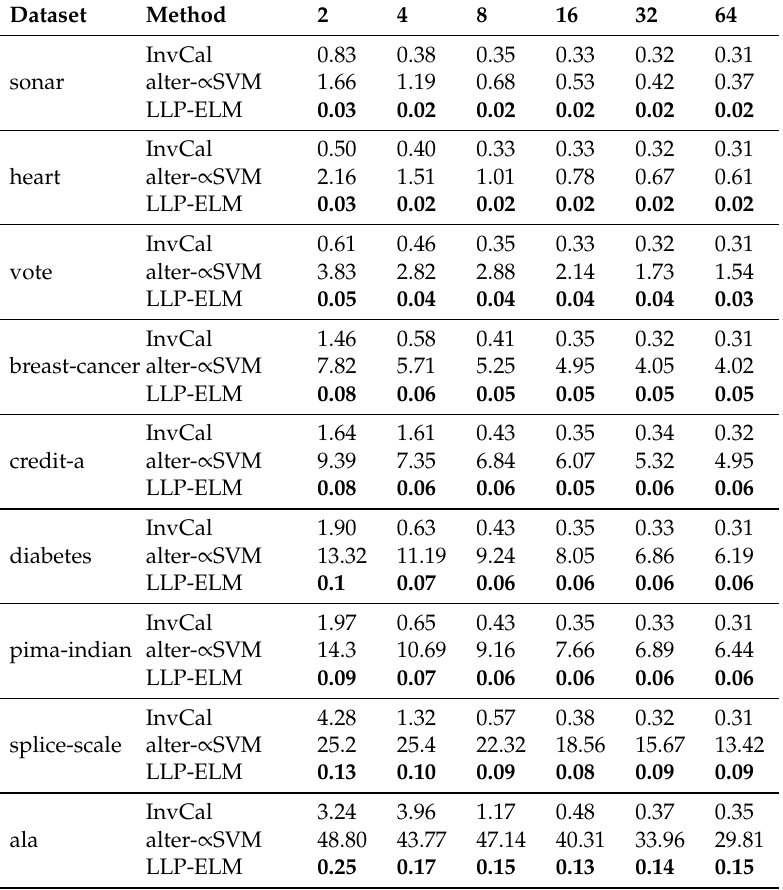
Table 3. Training time (second) of different algorithms with bag size 2, 4, 8, 16, 32 and 64. Bold numbers denote the least training